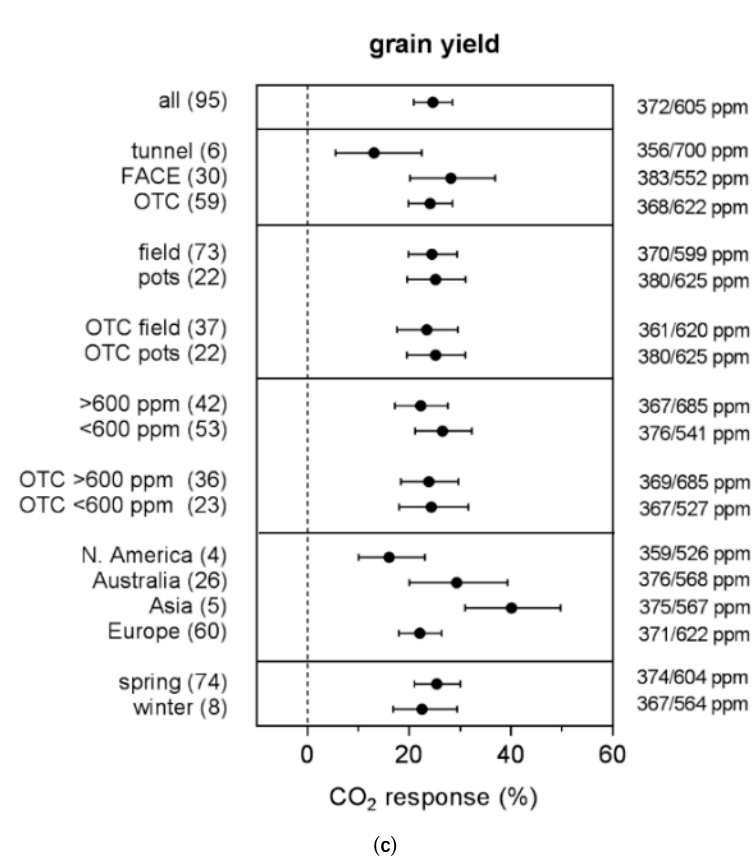
Figure 2. ( a ) Response function for grain yield (relative to yield at 350 ppm) with CO 2 concentration. Grey markers are statistical outliers excluded from the curve fitting. ( b ) Relationship between the grain yield CO 2 response for and Δ CO 2 (difference in CO 2 concentration between aCO 2 and eCO 2 treatment). Dotted lines represent the 95% confidence interval for regression models. ( c ) Meta-analysis of the eCO 2 effect on wheat grain yield using aCO 2 as the reference. Subgroup analysis for different exposure systems (FACE, OTC, and tunnel), rooting environment (pots and field soil), concentration level of eCO 2 treatment (above or below 600 ppm), region (North America, Asia, Australia, Europe), and wheat type (spring or winter wheat). The number of observation pairs is given within the brackets. The average concentration level for ambient and elevated CO 2 treatment is given at the right y -axis (aCO 2 /eCO 2 ). Table 1. Response functions for regression of yield variables (grain yield, total aboveground biomass, harvest index, grain mass, and grain number) with CO 2 concentration. 1